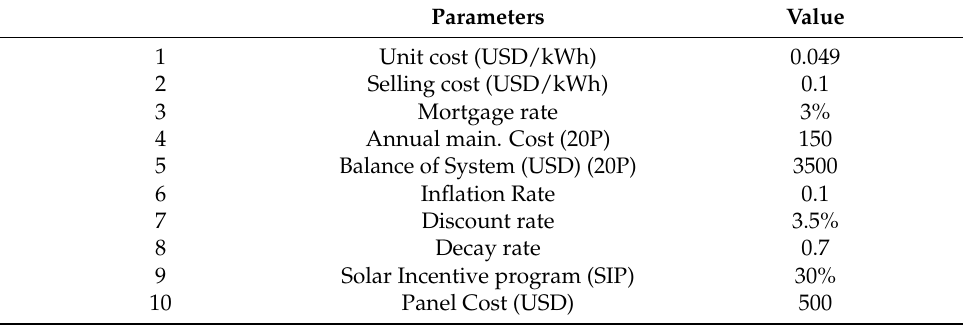
Table 5. Case 1 economic model chosen